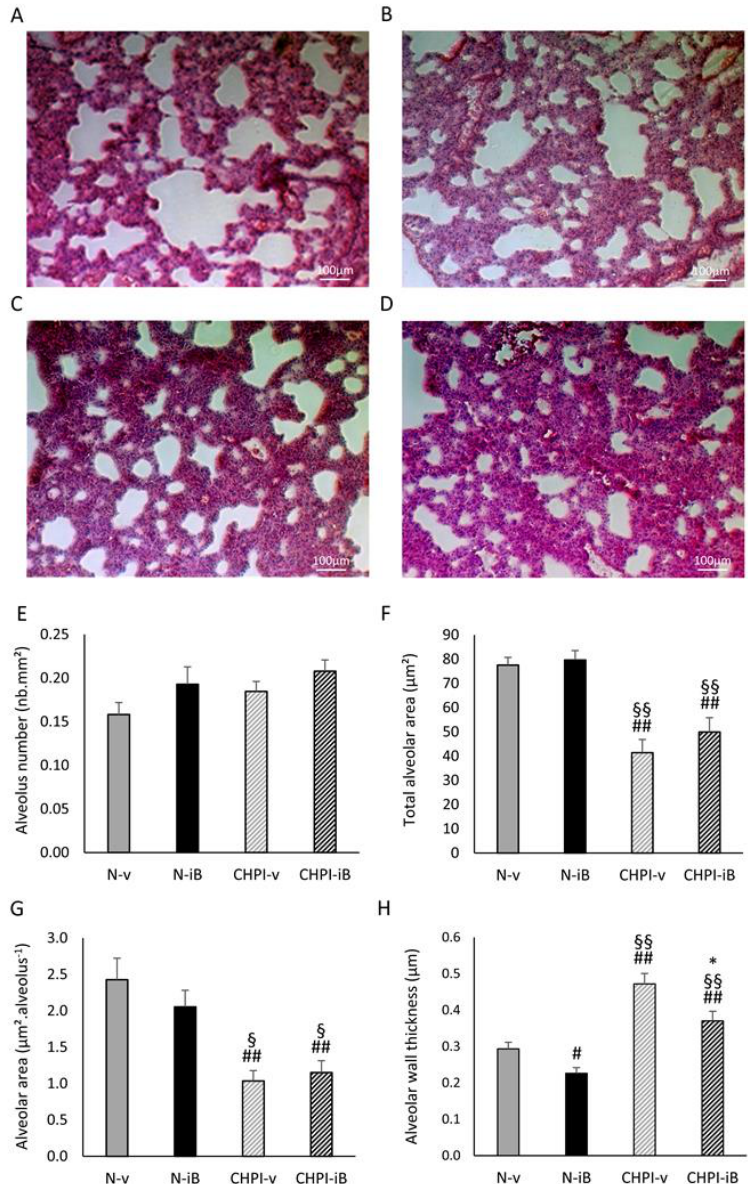
Figure 1. Effects of combined chronic hypoxia (CH) and pulmonary inflammation, induced by LPS instillations (PI), on the lung structure. Sectional view of lungs from N-v ( A ), N-iB ( B ), CHPI-v ( C ), and CHPI-iB ( D ) groups, under light microscope, after hematoxylin and eosin staining. Histograms represent the number of alveolus ( E ), the total alveolar area ( F ), the mean alveolus area ( G ), and the mean alveolar wall thickness ( H ) detected on each sectional view. All picture analyses were performed as described under the Materials and Methods section. N-v: Normoxia + vehicle; N-iB: Normoxia + I-BET151; CHPI-v: Chronic Hypoxia + Inflammation + vehicle; CHPI-iB: Chronic Hypoxia + Inflammation + I-BET151. (mean ± SEM; n = 7 – 8). #: diff. of N-v (#: p < 0.05; ##: p < 0.001); §: diff. of N-iB (§: p < 0.05; §§: p < 0.001); *: diff. of CHPI-v (*: p < 0.05).